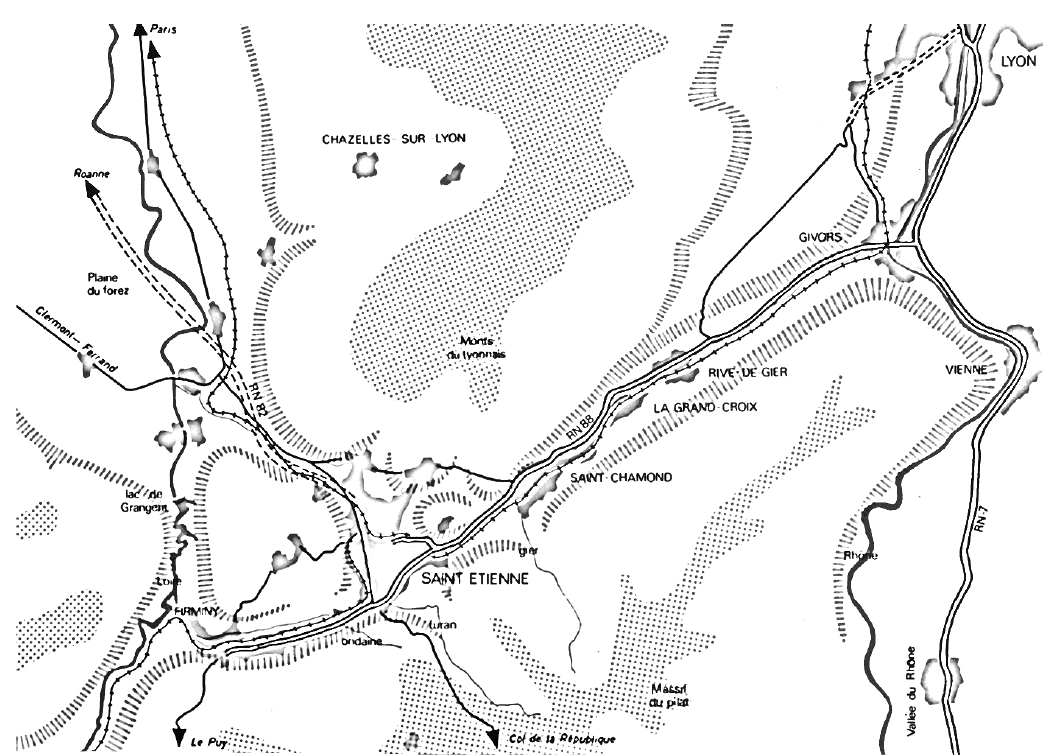
Figure 3. The Saint‐Étienne urban region. Source: OREAM